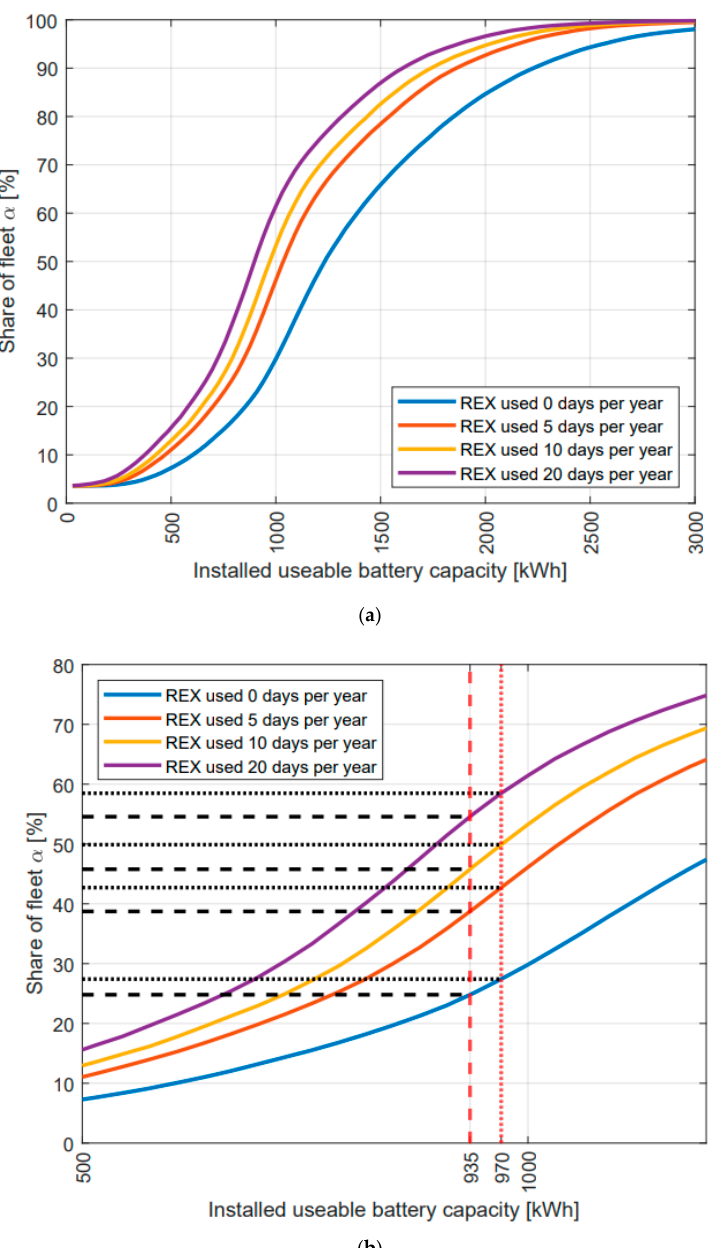
Figure 6. ( a ) Onboard energy storage needed to cover different fractions of the vehicles of the Scania fleet using BEV trucks showing how increasing REX utilization can either expand the coverage of vehicles that can be electrified or reduce the battery size while maintaining constant vehicle cover- age. ( b ) Expansion of the results plotted in Figure 6a focusing on the region around 1000 kWh.